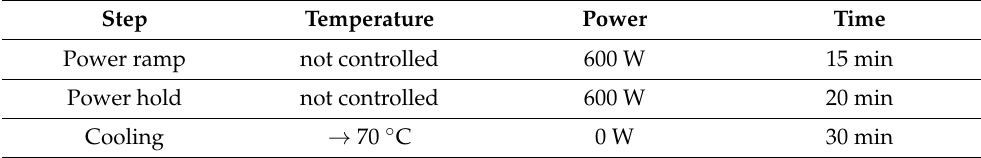
Table 5. The conditions of animal tissues microwave